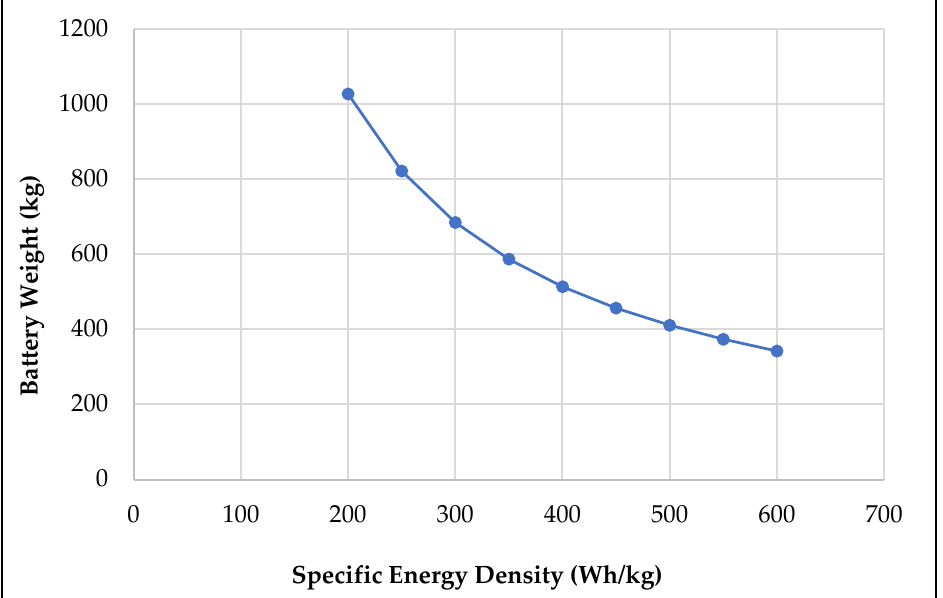
Figure 15. Battery weight versus specific energy density of battery.